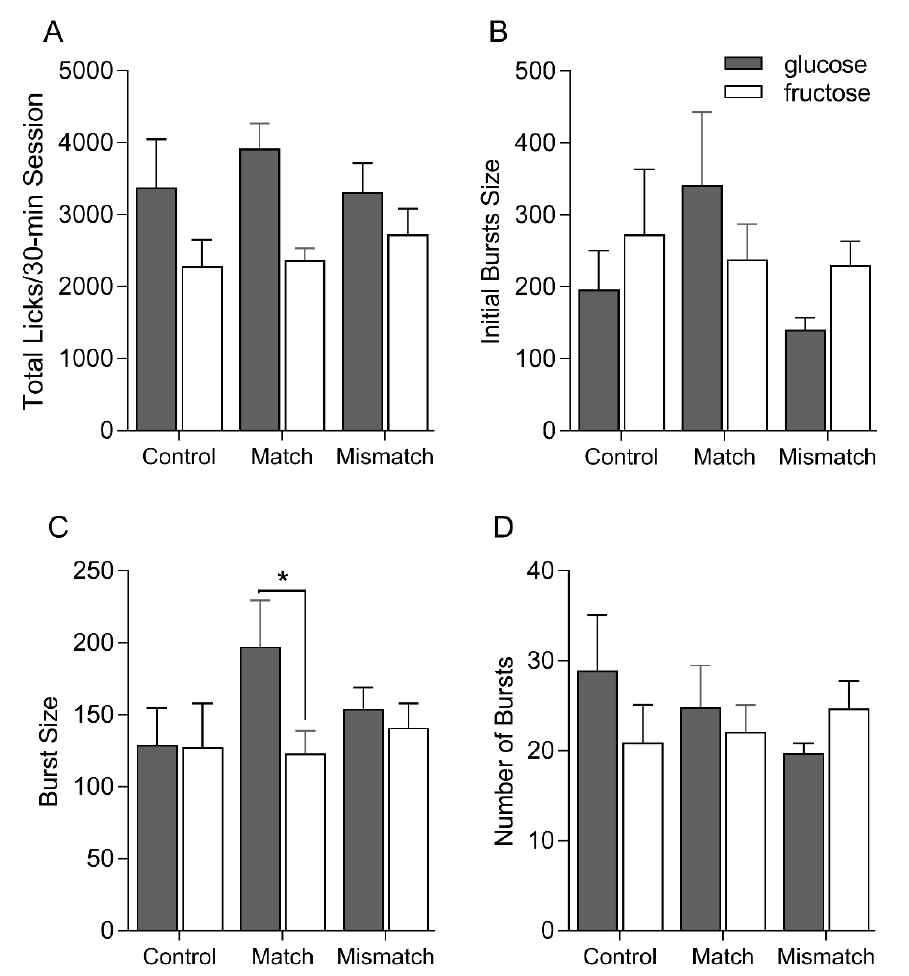
Figure 4. Mean ± SEM total licks ( A ), initial bursts size ( B ), overall burst size ( C ) and overall number of bursts (D) on the post-conditioning single-bottle 0.316 M glucose and fructose intake test sessions for Control, Matched and Mismatched groups. Significant differences are indicated by asterisks (*).